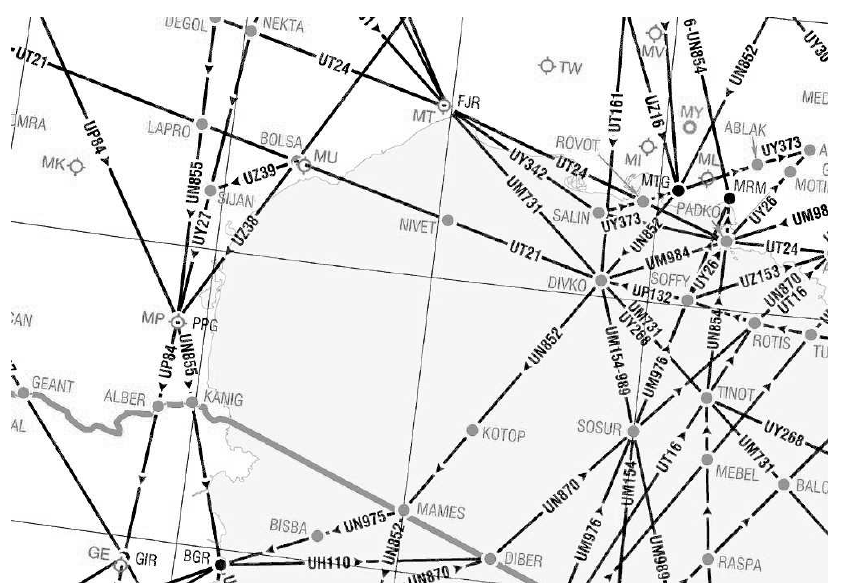
Figure 2. Excerpt of a map of the route network in the south of France. Routes are defined by waypoints—black and grey dots. Source: